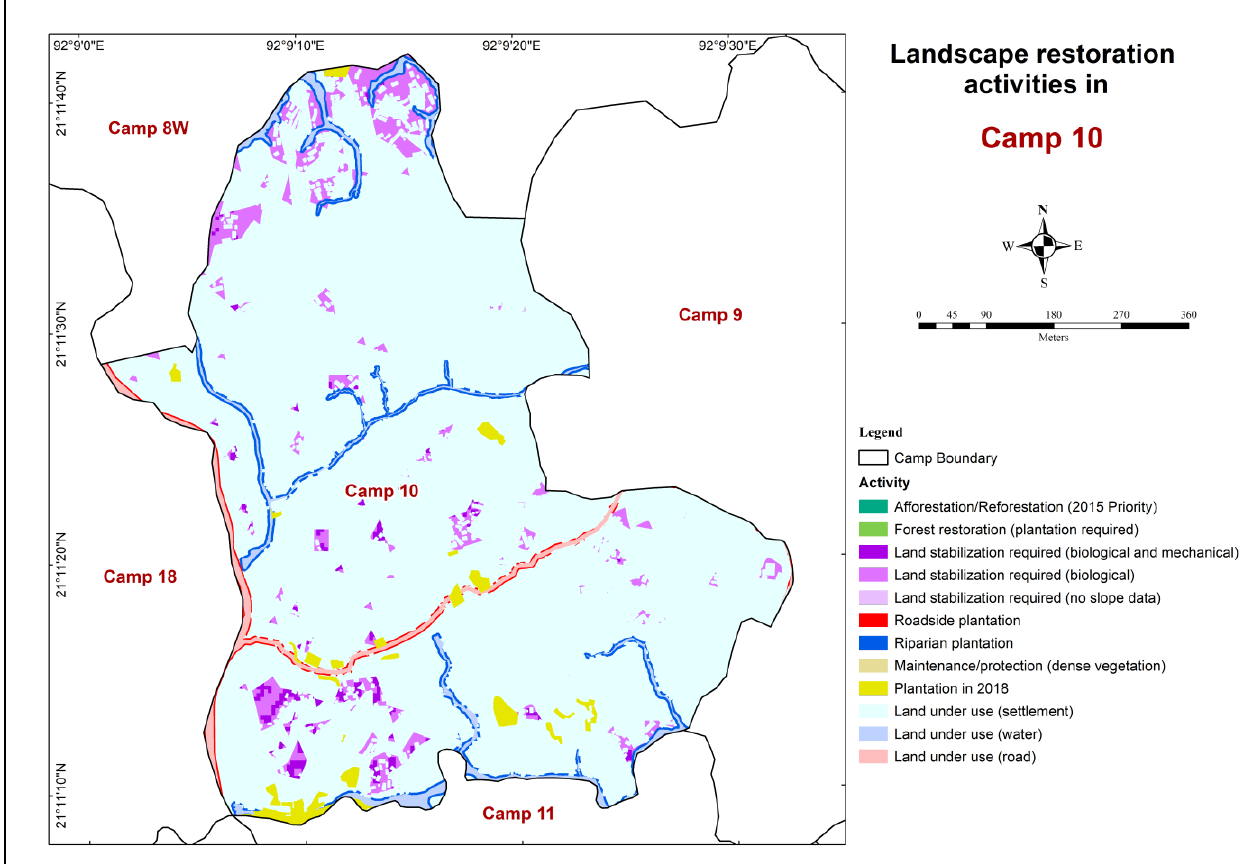
Figure 5. Land restoration plan map for Camp 10 in 2019.